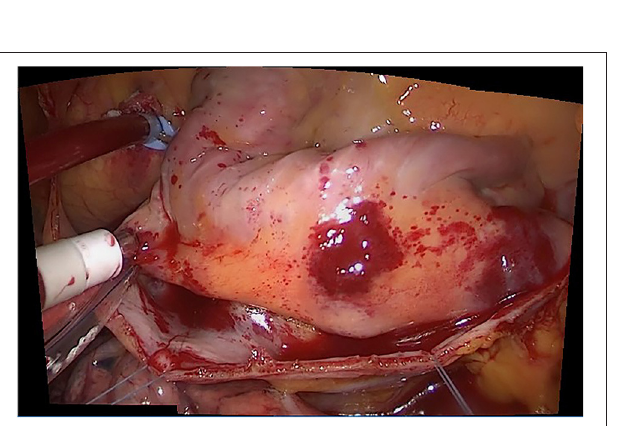
FIGURE 9 | The result of the improved SIFT